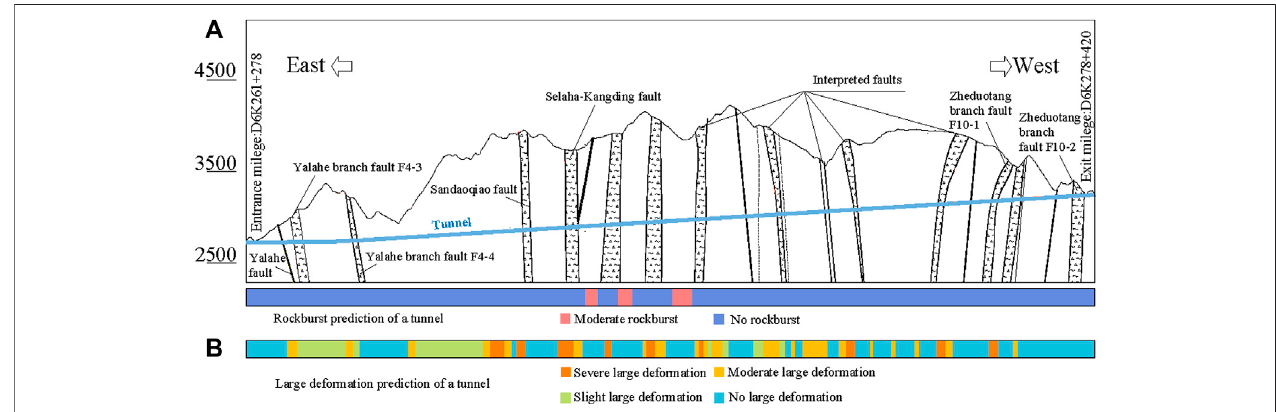
TABLE 4 | Large deformation grade (National Railway Administration of the People Republic of China, 2016). Deformation grade of soft rock